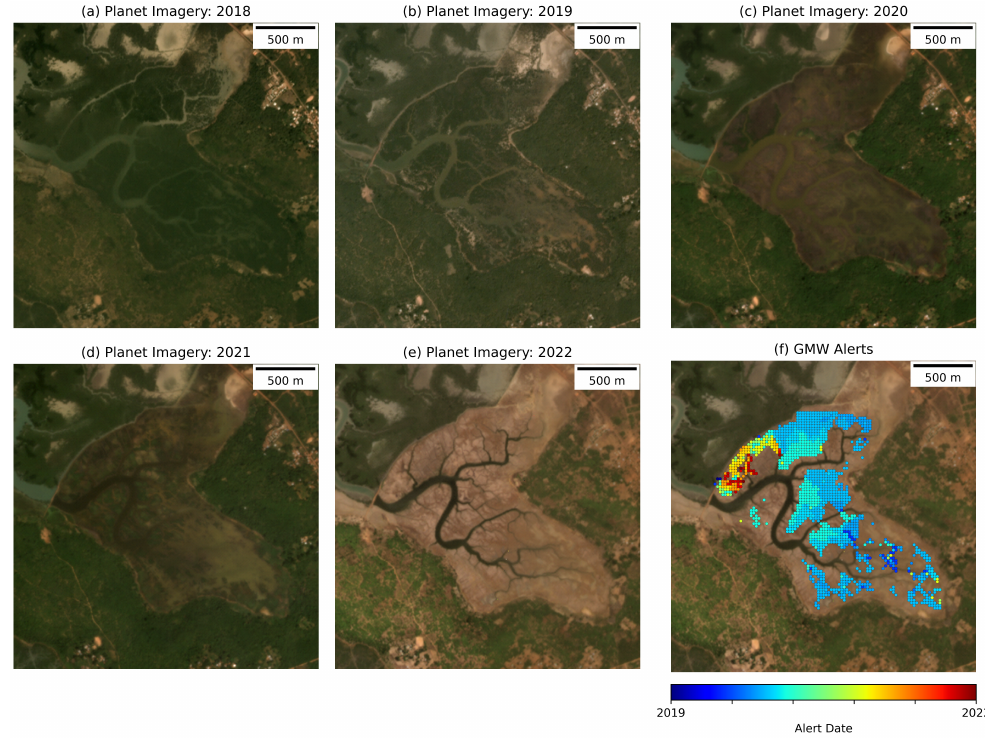
Figure 13. A case study from Guinea-Bissau where a new dam was built, resulting in the mangroves behind the dam being removed for rice cultivation. ( a ) illustrates the Planet imagery before the dam was built, ( b – e ) the dam was built and mangroves lost over the period and ( f ) the GMW Mangrove Loss Alerts identified over the period. (Image courtesy: Planet Labs/NICFI,